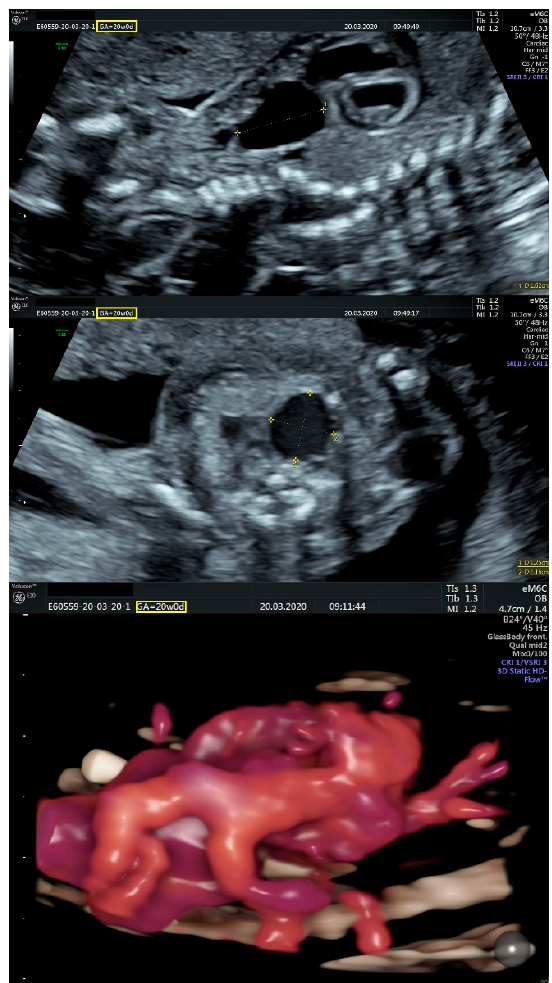
Figure 5. ( Top and middle ): ultrasonographic measurements of the aneurysm in sagittal ( top ) and transversal ( middle ) incidences; ( bottom ): 3D reconstruction of the mediastinal vessels.